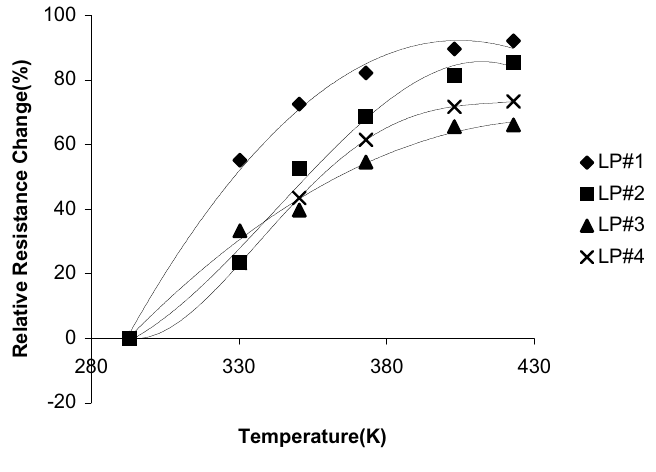
Figure 9. The relative resistance change expressed as a percentage against increasing temperature for the In O /SiO samples produced at low 2 3